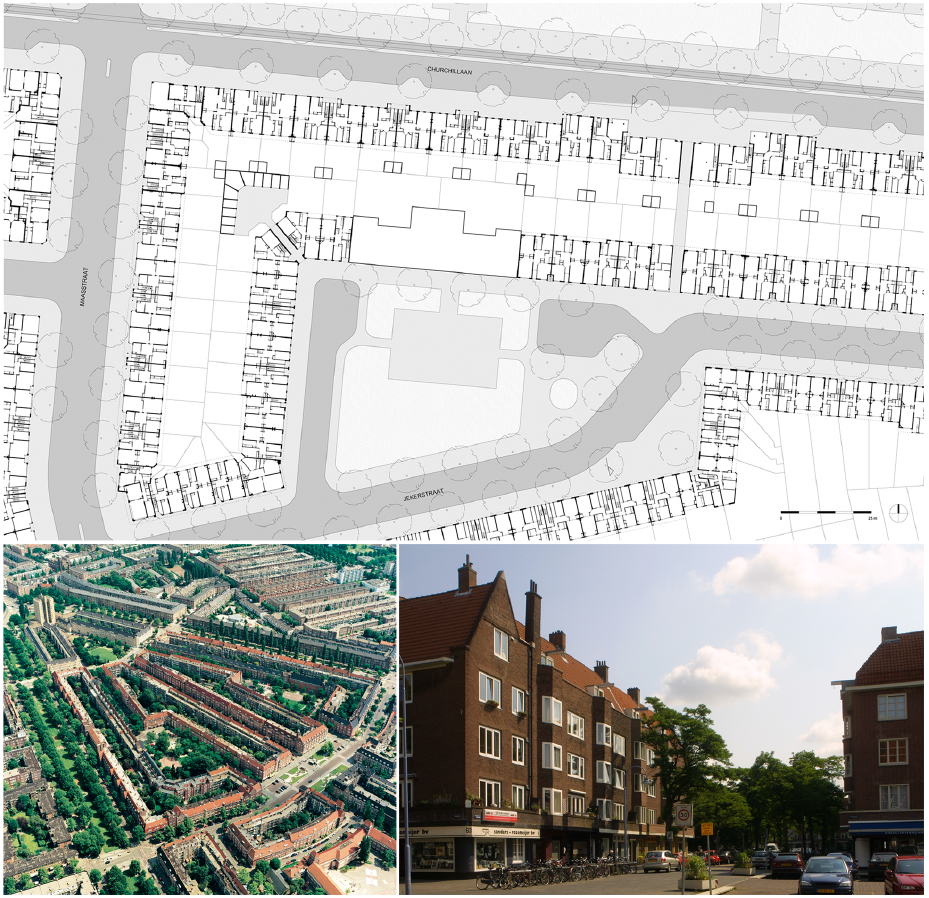
Figure 2. Berlage’s Amsterdam Zuid city extension. Top: Ground floor plan 1:500. Bottom, left to right: Aerial image of Amsterdam Zuid city extension; streets lined by shops and the boulevards linking the city extension areas of the south and the quiet living quarters grouped around squares. Notes: The hierarchy is clearly distinguishable, and the last photograph shows an urban corner between the boulevard and the street leading to the inner city. Source: